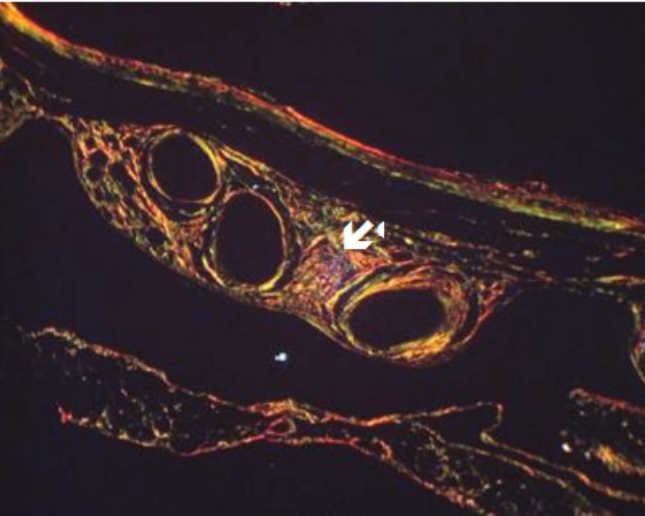
FIGURE 5 - Note numerous collagen fibers (arrow) birefringent with the polarized light amongst the fibers of the mesh (Group 2), featuring moderate fibrosis. Picrosirius red